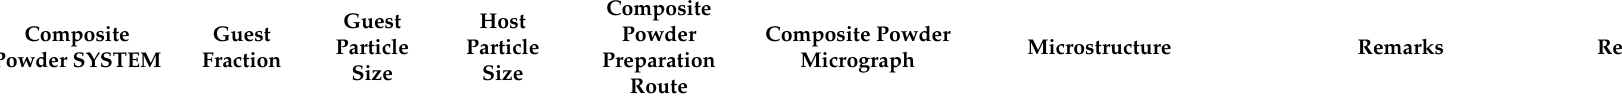
Table 2. Aluminum matrix composites (AMCs) and titanium matrix composites (TMCs) fabricated in recent years by SLM processing of composite powder feedstocks. Composite